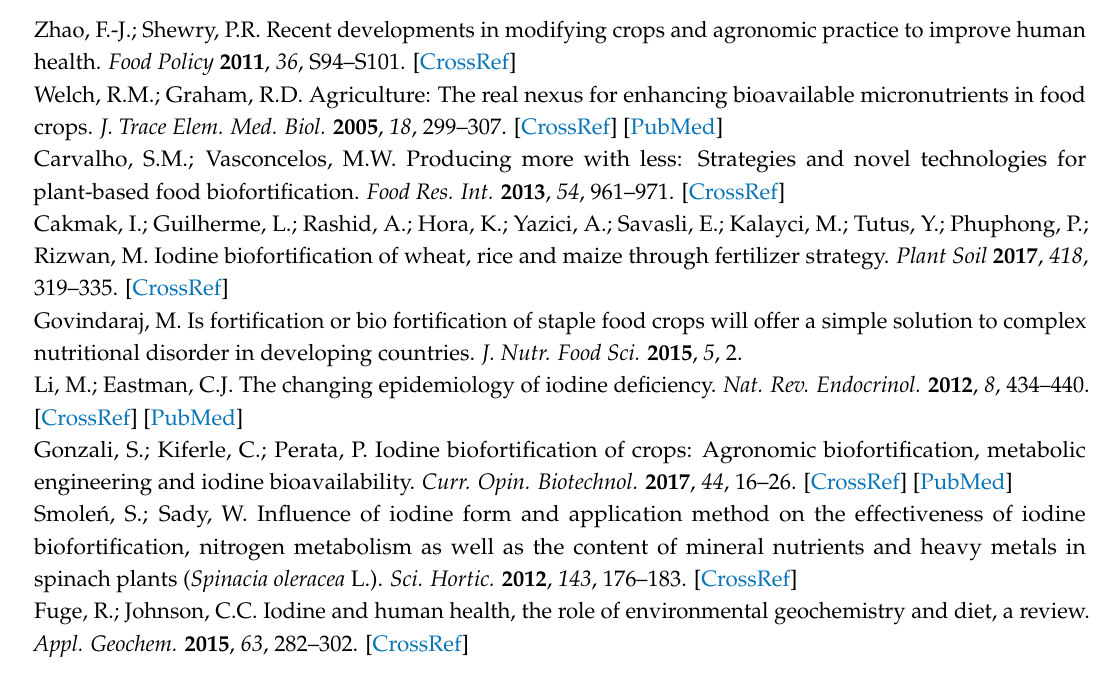
Figure S1: Global priority scores of the academic group, Figure S2: Global priority scores of NGO representatives, Figure S3: Global priority scores of government extension representatives, Figure S4: Global priority scores of CDO, Figure S5: Global priority scores of agro-input companies, Figure S6: Global priority scores of the elite farmers’